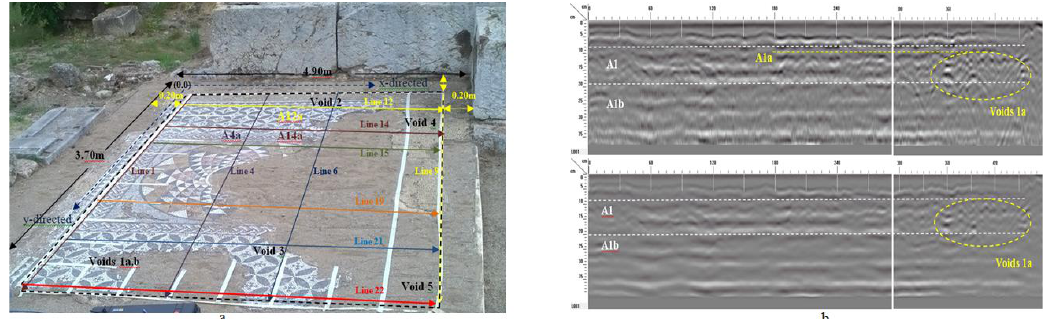
Figure 9. ( a ) The 2D radar data acquisition along single profile lines in the x- and y- directions of the mosaic floor, ( b ) The 2D radar profile acquired along the y- directed line 1, time zero, and migrated profile. (Reprinted with permission from Ref. [24]. Copyright: 2017 Ftikou, Ε .; Theodorakeas, P.; profile. (Reprinted with permission from Ref. [24]. Copyright: 2017 Ftikou, E.; Theodorakeas, P.; Cheilakou, Ε . ; Koui, Μ .). Cheilakou, E.; Koui,